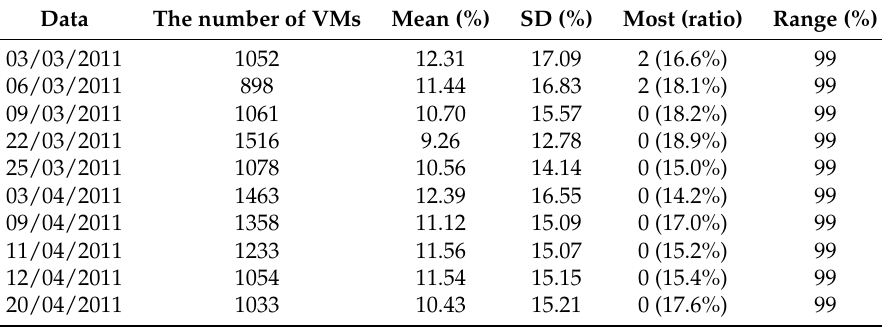
Table 1. Characteristics of the workload (CPU